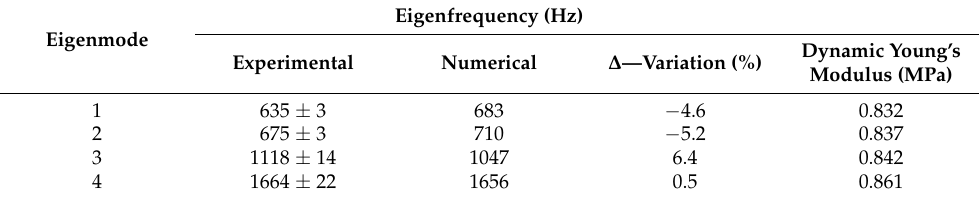
Table 3. Comparison between experimental and numerical eigenfrequencies in half-cane samples.